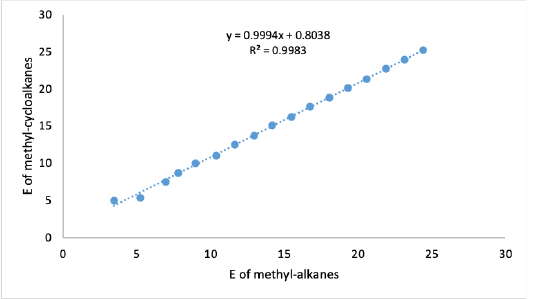
Figure 3. Correlation between graph energy of methyl-alkanes and methyl-cycloalkanes.